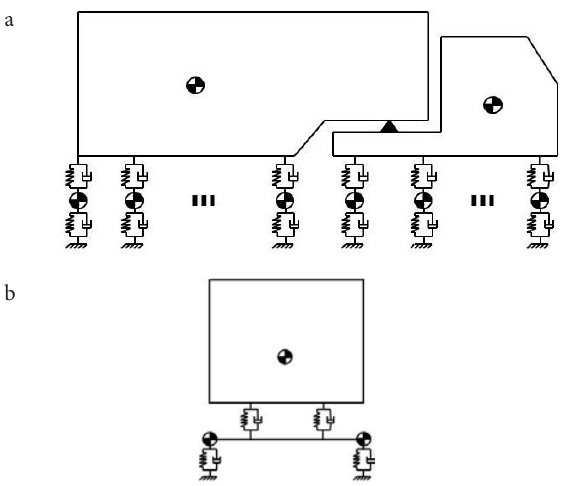
Fig. 2. General vehicle model: a ‒ side elevation; b ‒ cross-